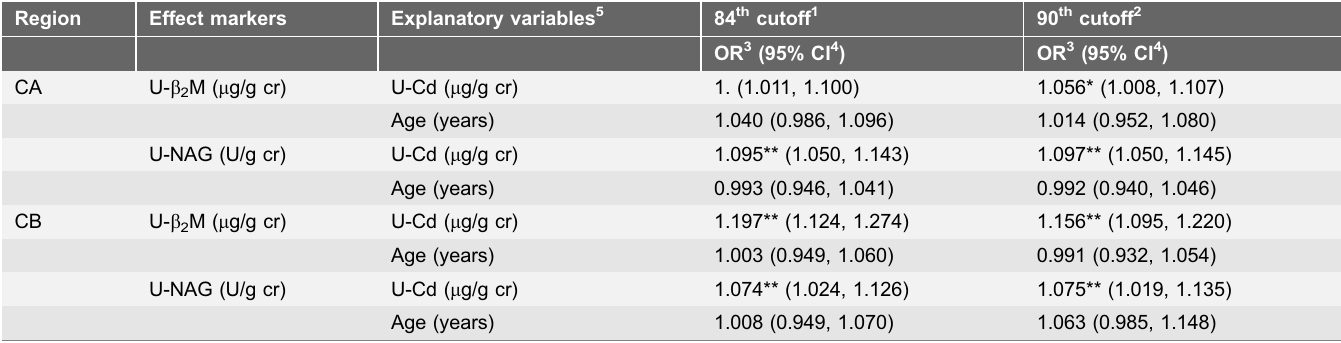
Table 4. Results of the logistic regression analysis on individual factors related to Cd-induced renal tubular damage.